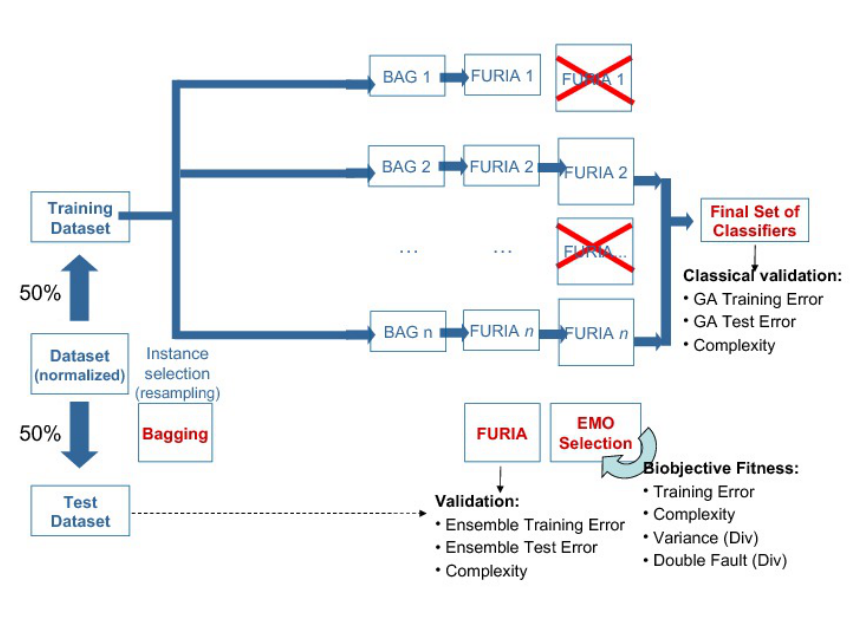
Figure 2: Our framework: after the instance and the feature selection procedures, the component classifiers are derived by the FURIA learning method. Finally, the output is obtained using a voting-based